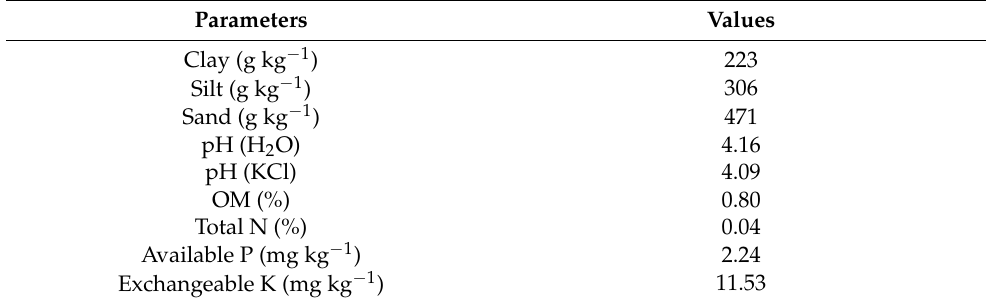
Table 1. Main physical and physico-chemical properties of the soil used in the